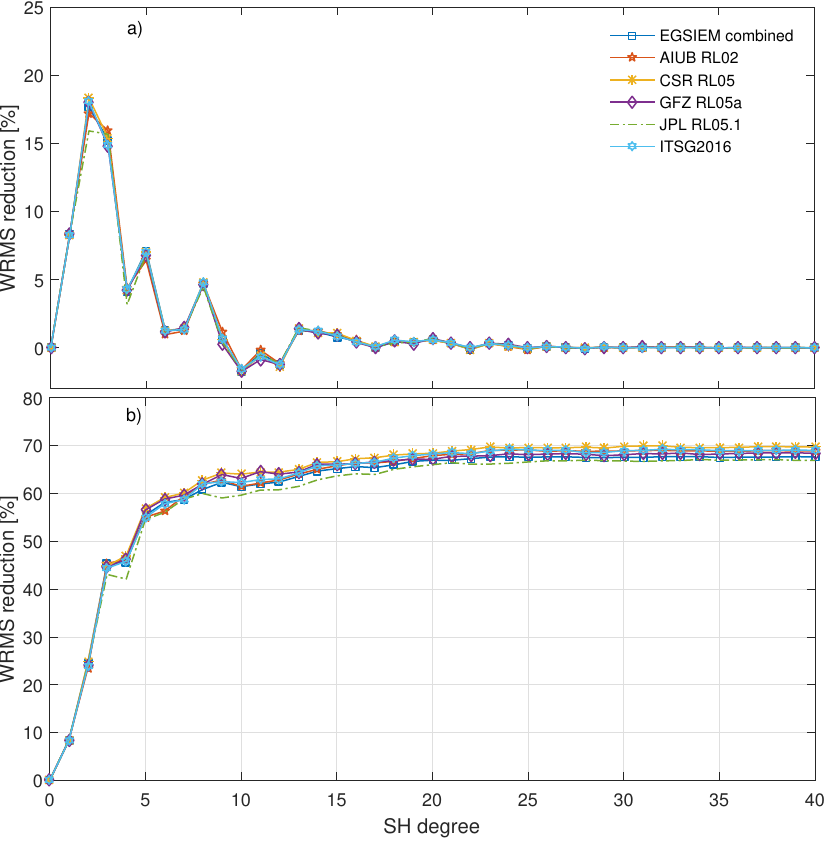
Figure 4. Median degree WRMS reductions ( a ) and cumulative degree WRMS reductions ( b ) of different gravity solutions using the ITRF2014 residuals at the annual signal level over 928 GNSS stations